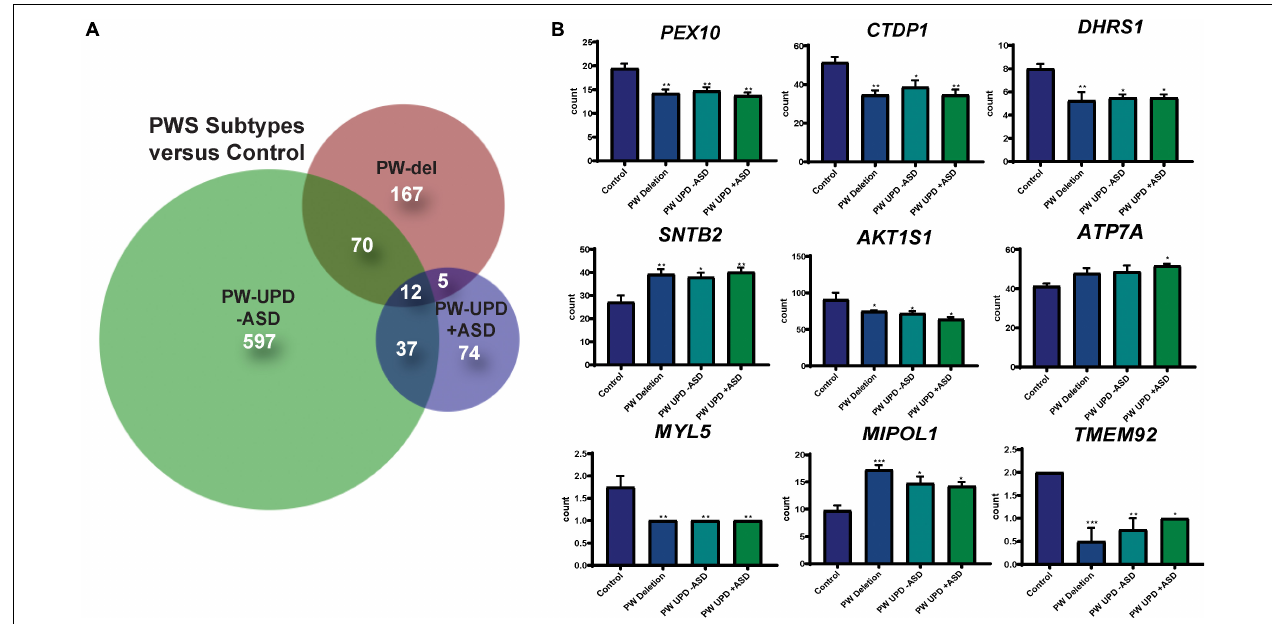
FIGURE 3 | DPSC-derived neuronal cultures define PWS subtype specific expression and a core PWS molecular signature. (A) Venn diagram using all the significantly differentially expressed transcripts (p-value ≤ 0.05, FDR ≤ 0.05) versus control for each PWS subtype created using BioVenn (Hulsen et al., 2008). (B) Individual bar graphs showing mean counts per transcript across all groups for each of the transcripts located outside of the PWS critical region and identified as common across all PWS subtypes. These 9 genes, along with MAGEL2, SNRPN, and SNURF , represent a core molecular signature for PWS associated changes in neurons. Significance was determined by individual t -tests versus control for each subgroup ( p ≤ 0.05). * = p -value ≤ 0.05, ** = p -value ≤ 0.01, *** = p -value ≤